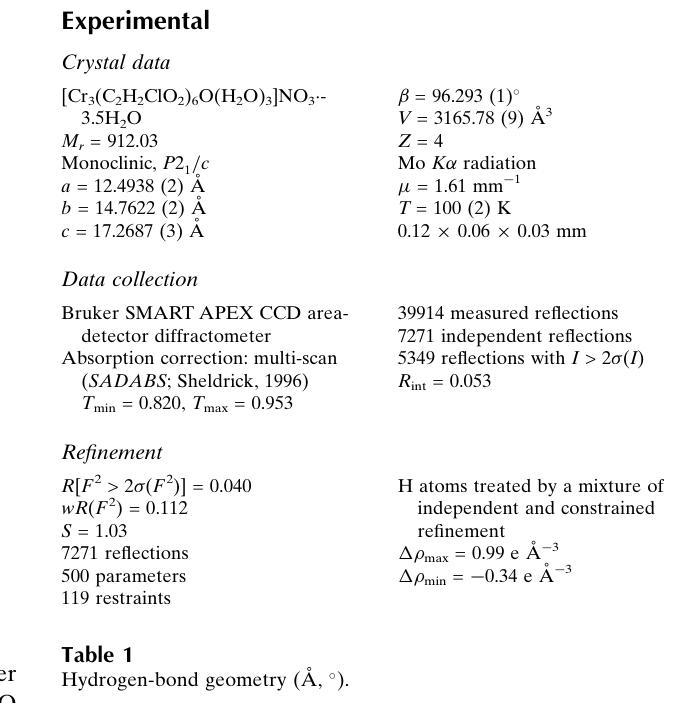
Hydrogen-bond geometry (A˚ , (cid:2) ).